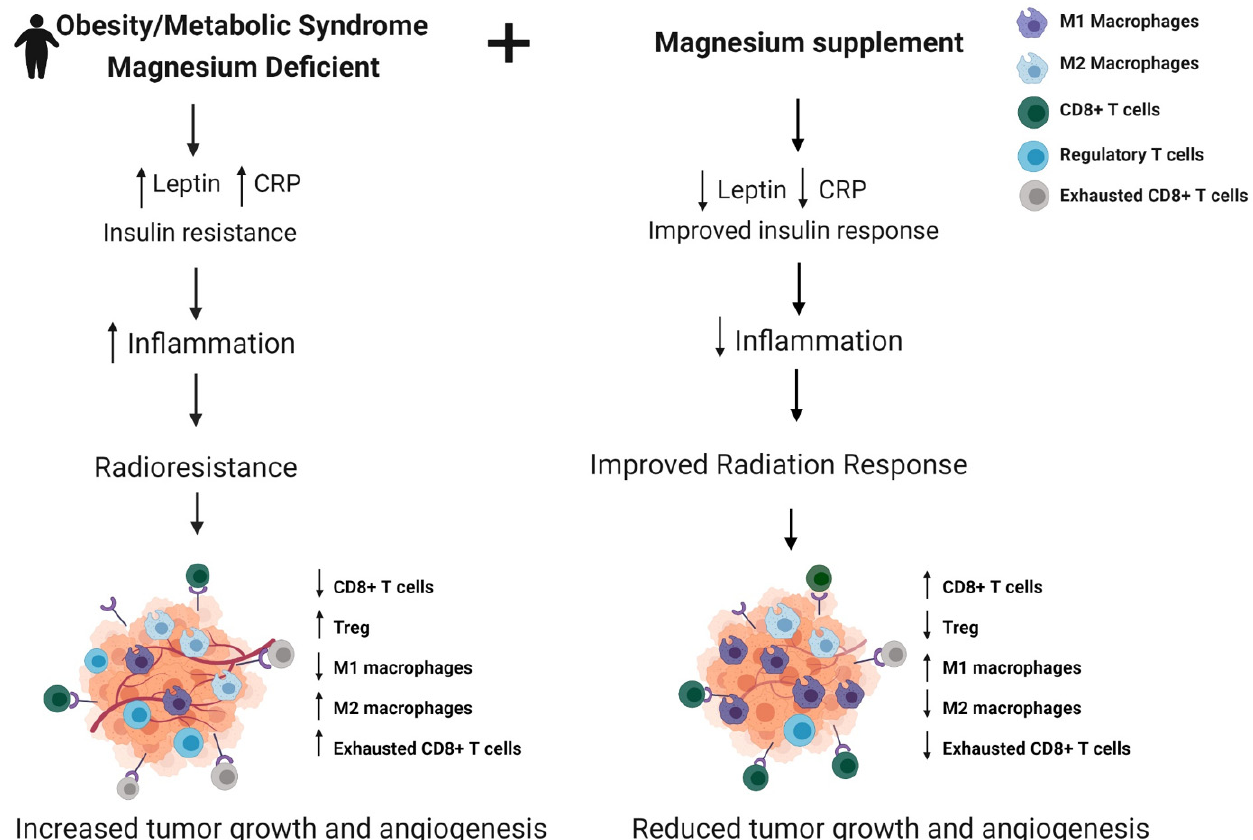
Figure 2. Magnesium supplementation to modulate antitumor immune response and radiation sensitivity in breast cancer patients with obesity/metabolic syndrome. Magnesium deficiency is commonly observed in individuals with obesity and metabolic syndrome and is associated with increased insulin resistance and inflammation in these patients, leading to radiation resistance and tumor growth. Modeling supplementation with Magnesium, radiation response would be improved by increasing insulin sensitivity and antitumor immune response. Created with BioRen- der.com.